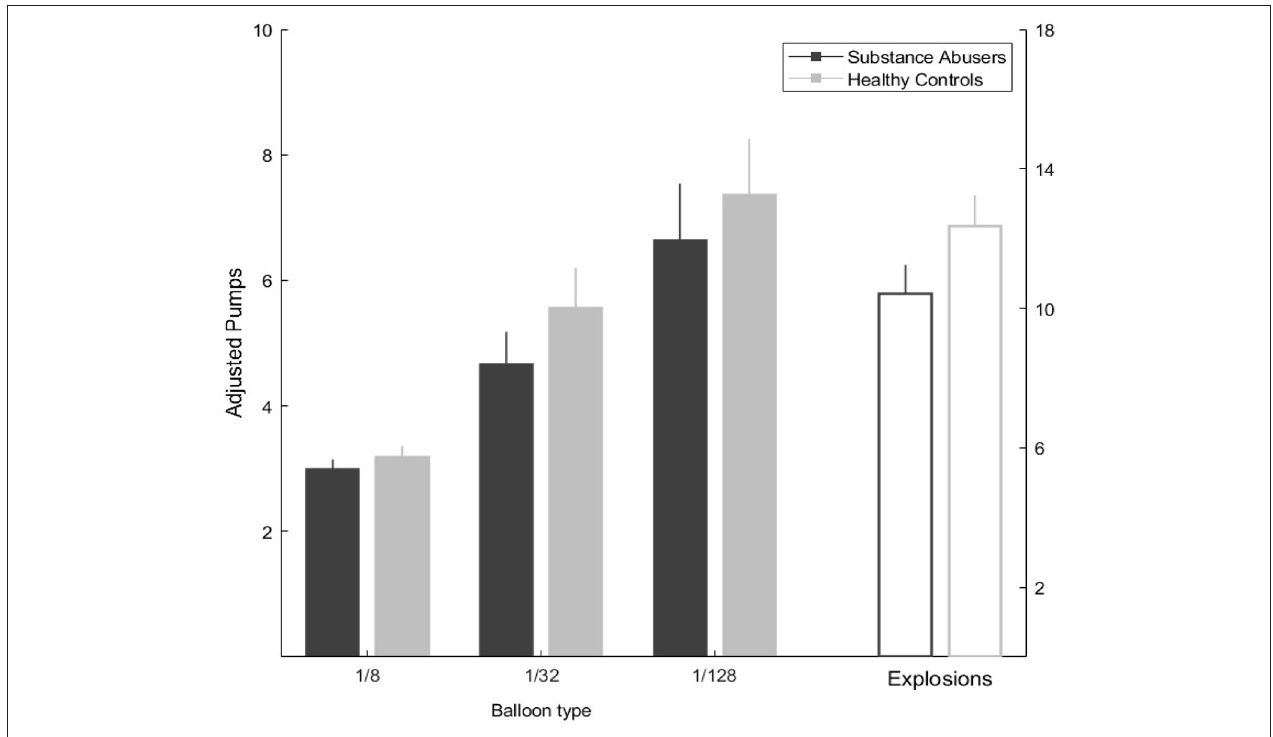
FIGURE 3 | Iowa Gambling Task performance during the five blocks and the mathematical model fit.